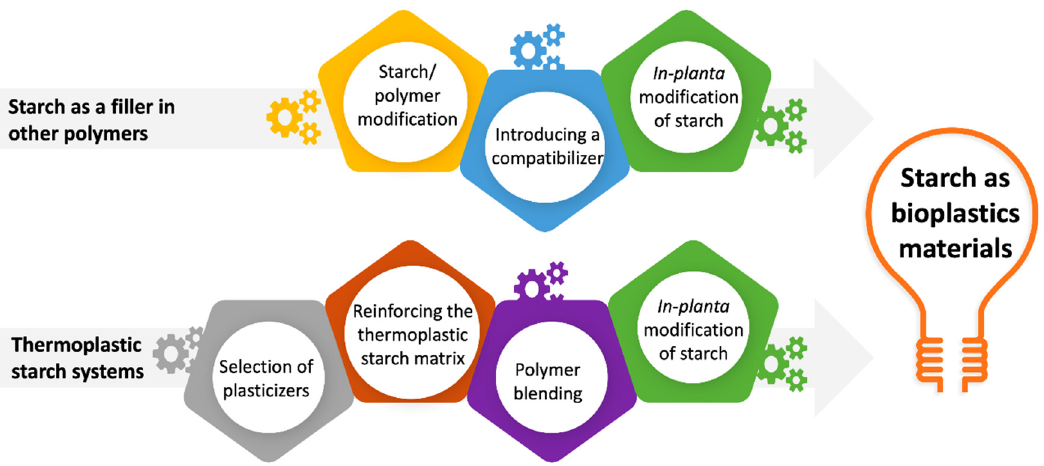
Figure 2. Use of starch in bioplastics applications and strategies to improve the properties of starch- based bioplastics materials.